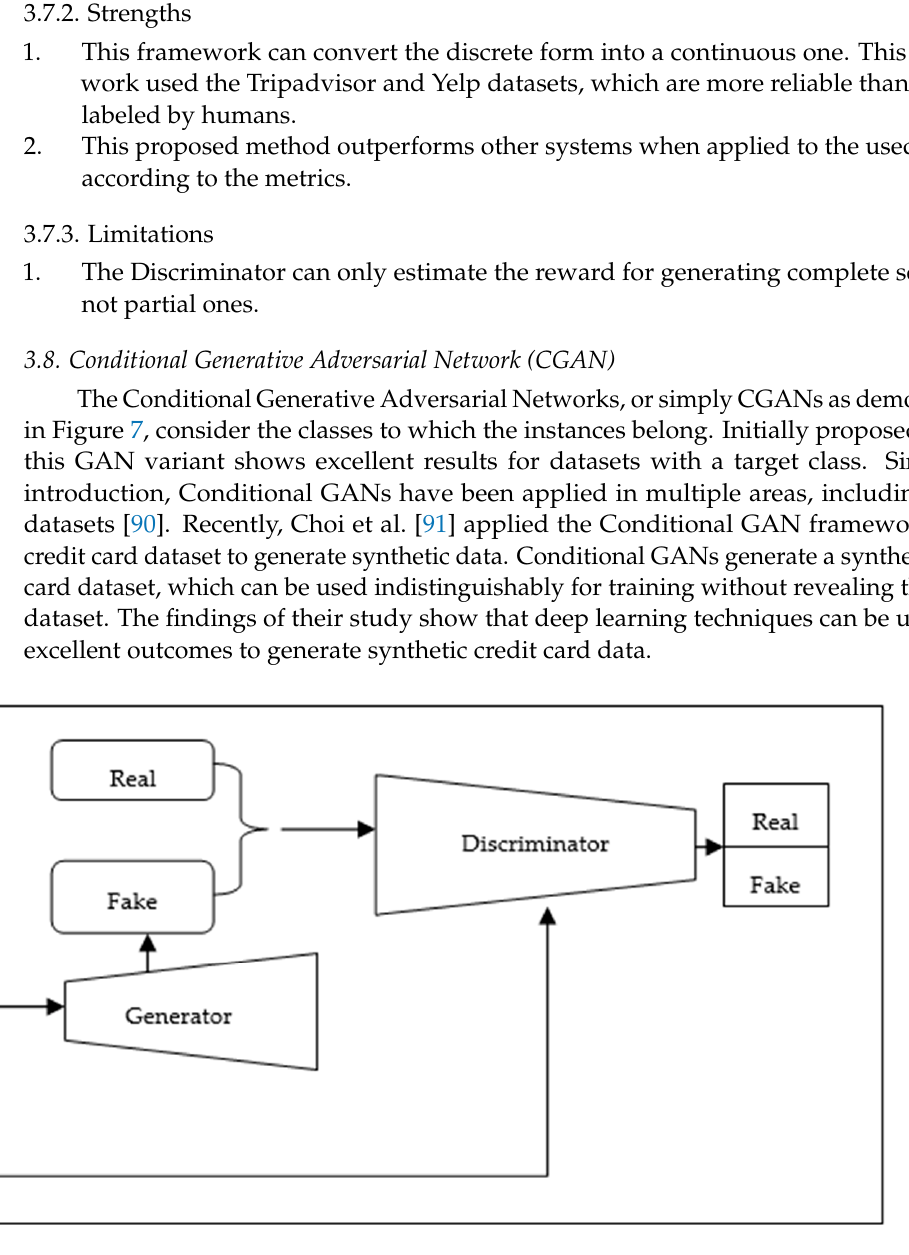
Figure 7. The Conditional GAN design is quite similar to the design of the conventional GAN, except the addition of class C, to which the instances belong.